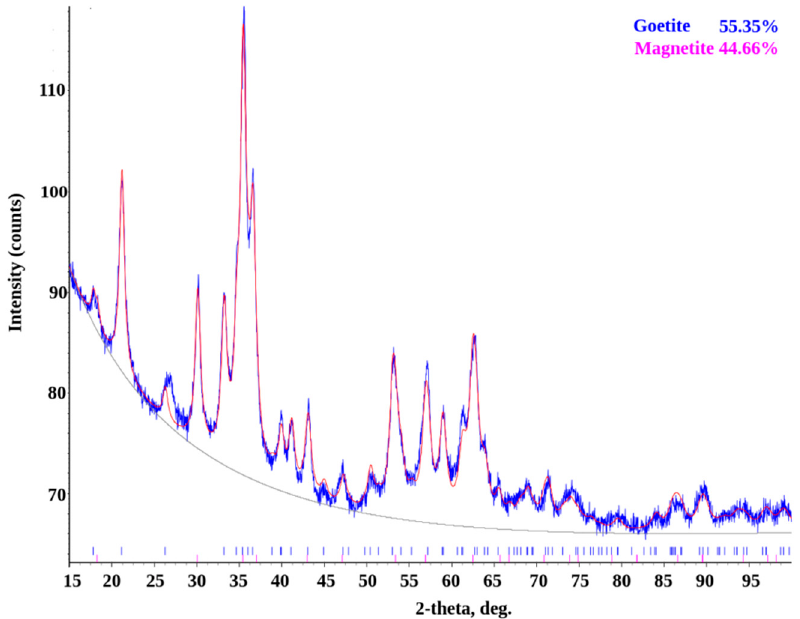
Figure 10. Diffractogram of the of the U7 surface compounds. Vertical bars at the bottom of the graph mark the peak positions of the identified phases.